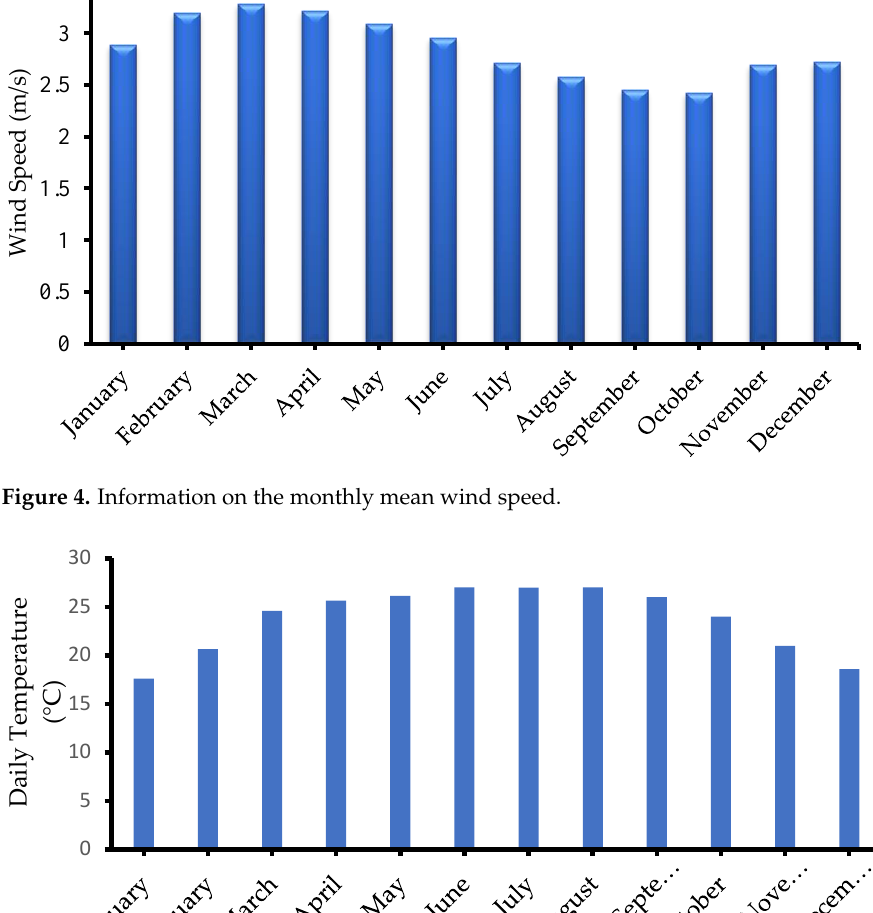
Figure 3. Monthly average solar global horizontal irradiance (GHI) data.